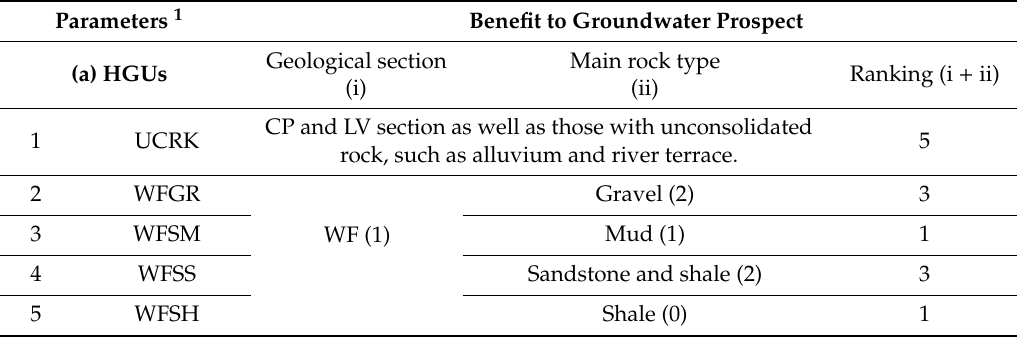
Figure 5. The six thematic maps of ( a ) hydrogeological units (HGUs), ( b ) lineament density (LD), ( c ) slope degree (SD), ( d ) drainage density (DD), ( e ) topographic wetness index (TWI), and ( f ) variation of the soil moisture index (VSMI), were computed by the normalized groundwater potential index (NGPI) as the raster-based empirical GIS model in the ArcGIS Spatial Analyst module with a spatial resolution of 30 m × 30 m. Table 2. Ranking and value of each parameter and its benefit to groundwater prospect.